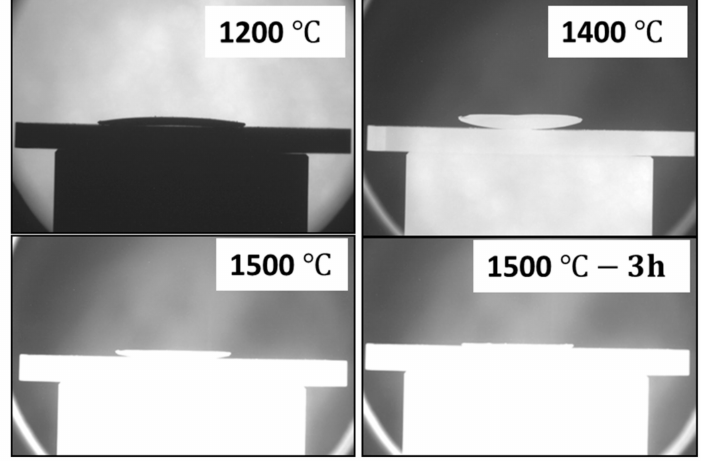
Figure7. Selectedsequenceshowingthecurvaturedevelopeduponco-firingtheBZCY(54) 8 / 9 2half-celltaken with the optical dilatometer. (Electrolyte layer is facing upward with the NiO- BZCY(54) 8 / 9 2